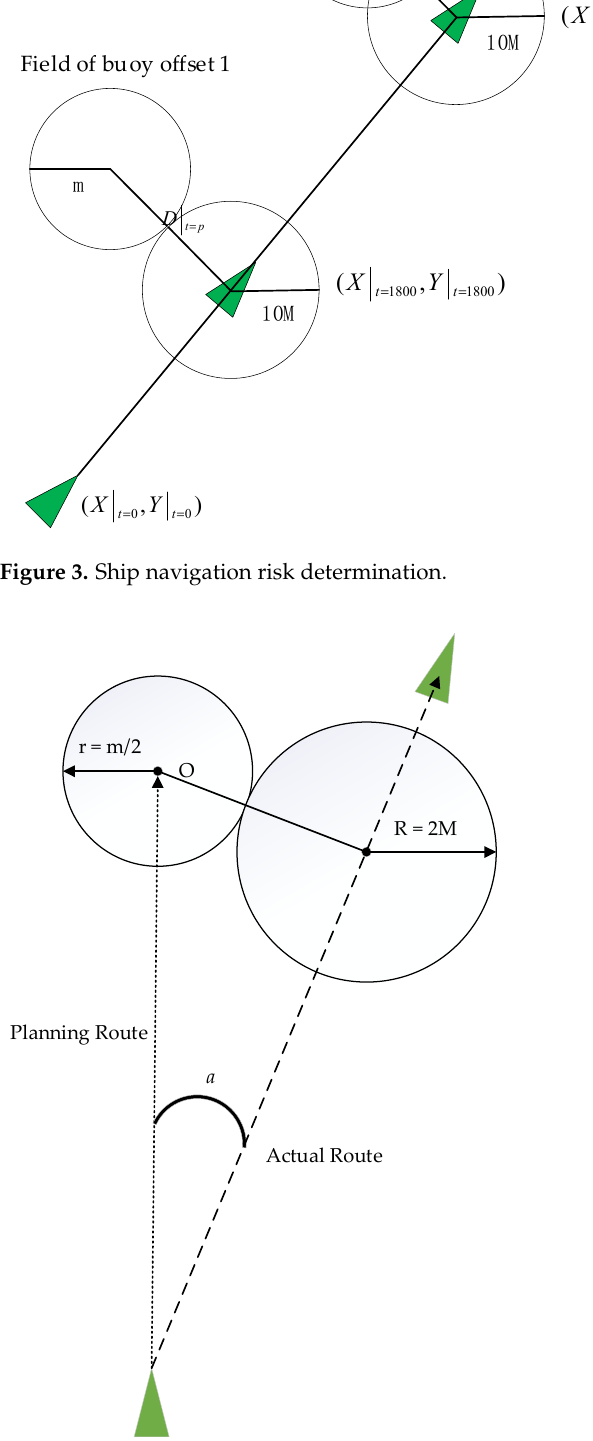
Figure 4. Ships avoid navigation